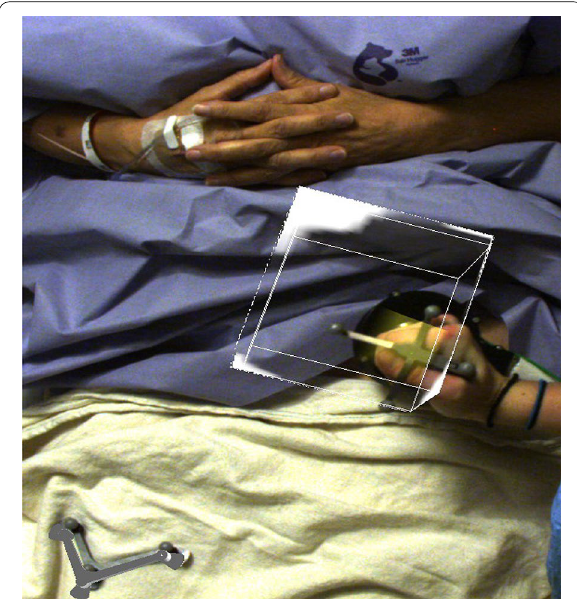
Fig. 4 Subject being scanned with the camera fhSPECT system. The box indicates the volume that will be